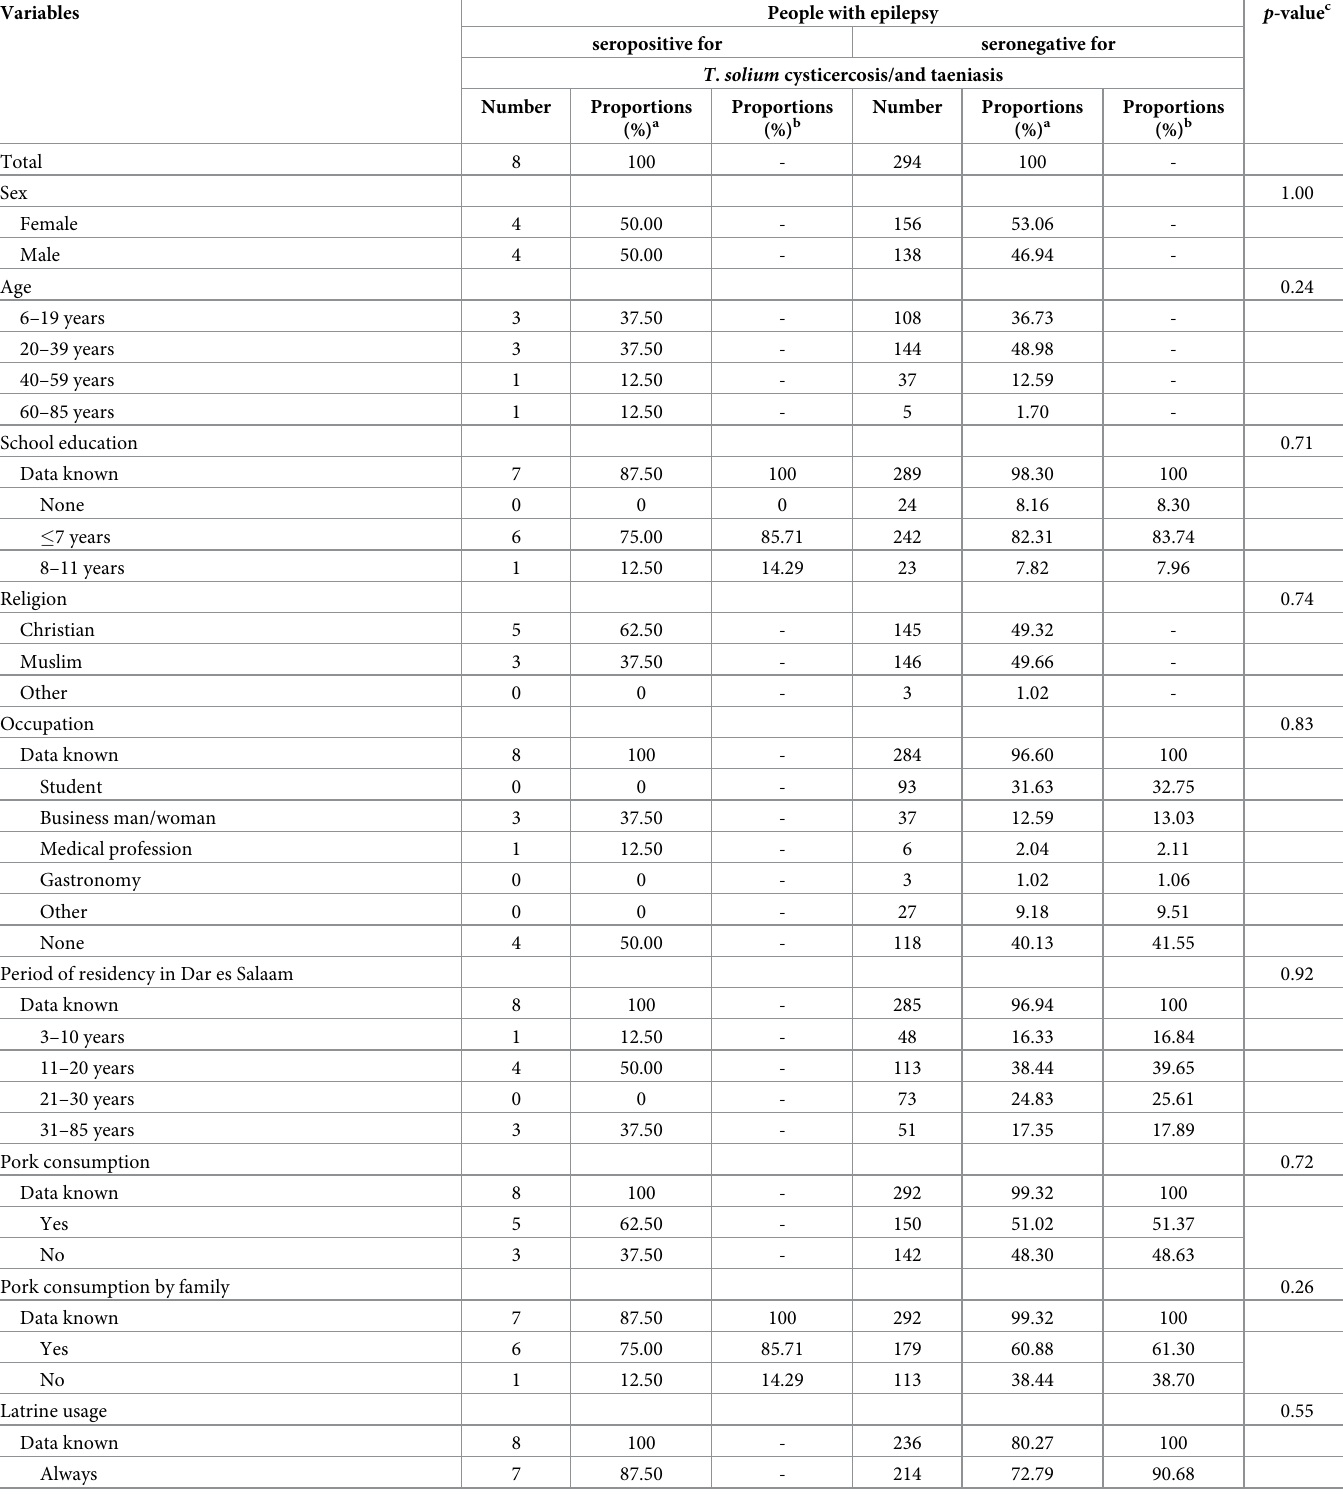
Table 1. Socio-demographics and associated factors for T . solium cysticercosis and taeniasis among people with epilepsy.